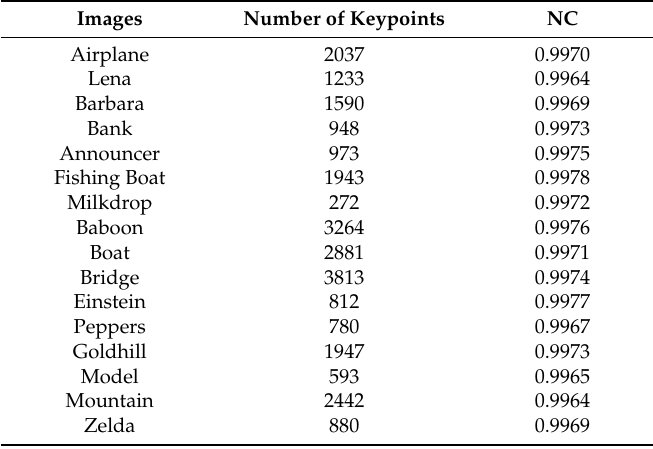
Table 1. Experimental results on test images.